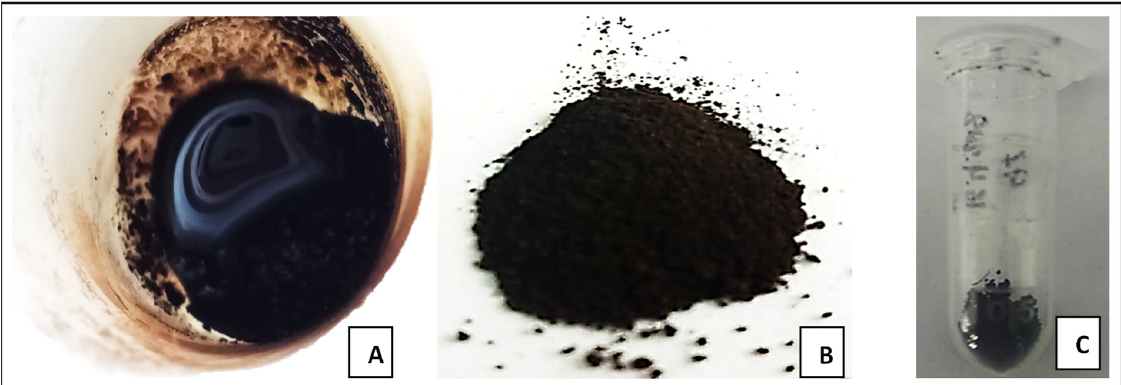
Figure 2. Melanin pigment of G. oxydans FBFS 97 during the extraction process ( A ), purified melanin powder ( B , C ).